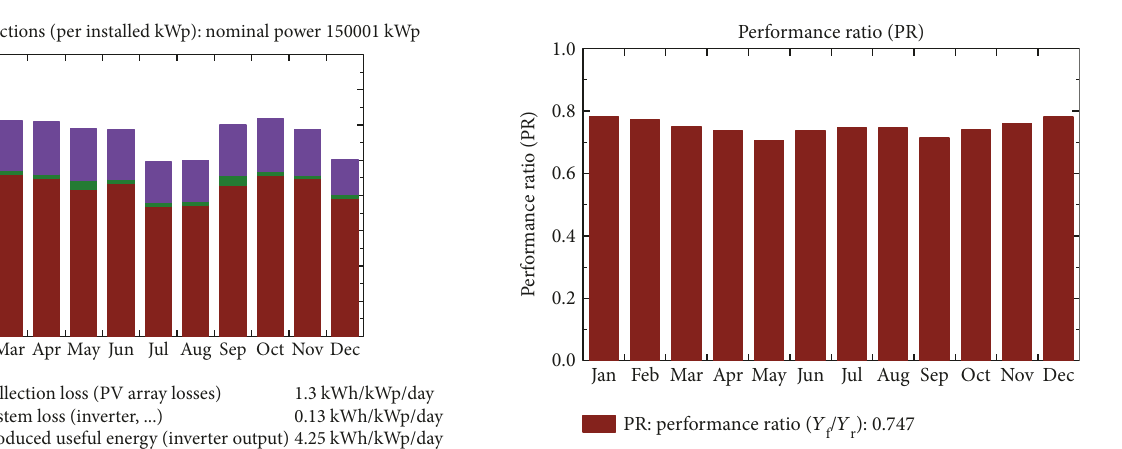
Figure 5: Monthly graph of normalized production (per